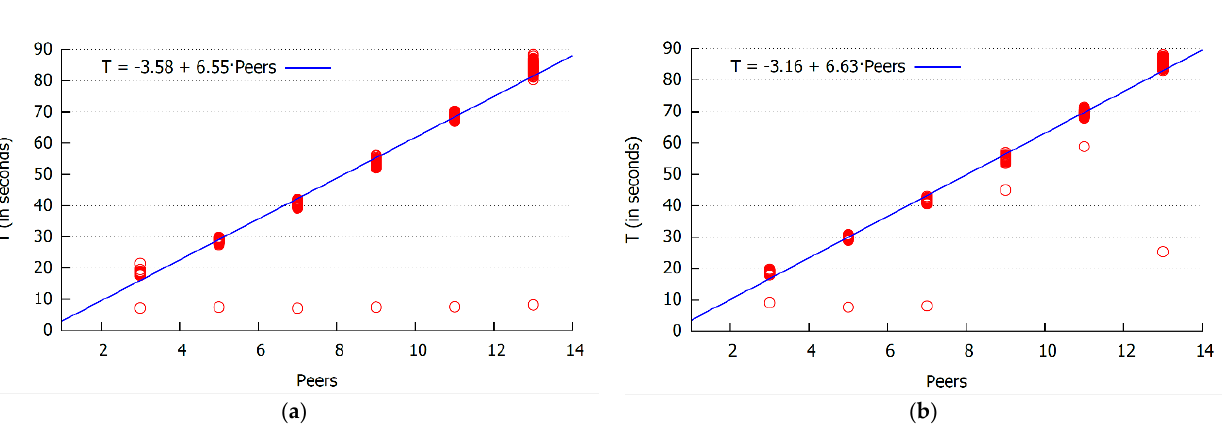
Figure 12. Model inference runtime (in seconds) in relation to the network size for the largest variant of EEG eye state dataset: Chaincode ( a ) and oracle service ( b ) results. The linear relationship is evident, where an additional peer in the network increases runtime T by 6.55 s for the chaincode and 6.63 s for the oracle service.